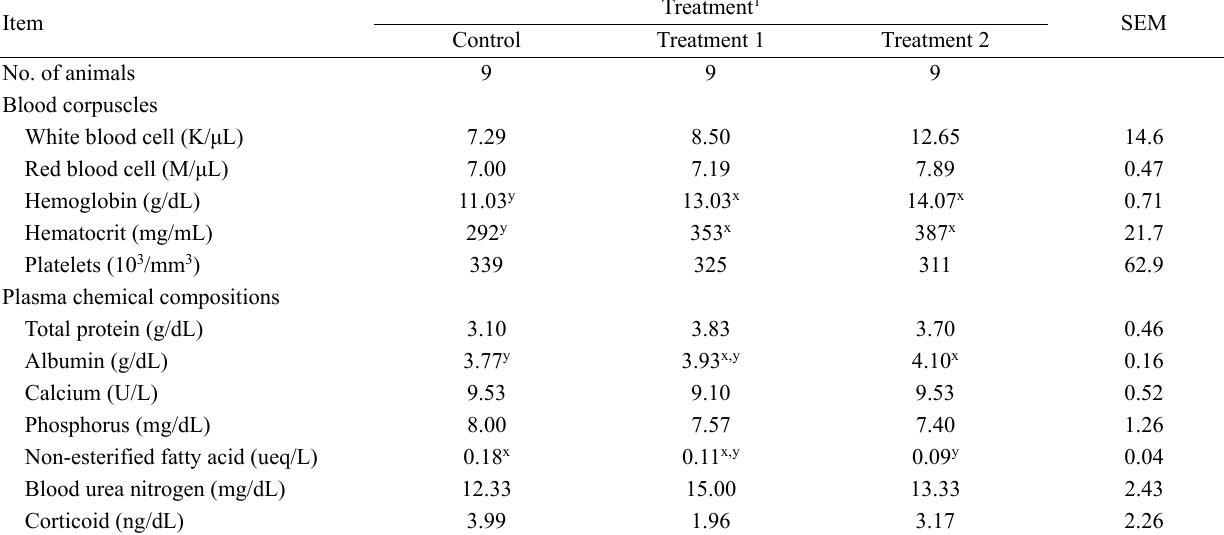
Table 4. Substitution effect of a total mixed ration by medicinal plant by-products on blood corpuscles and plasma chemical composition in the late fattening period of Hanwoo steers